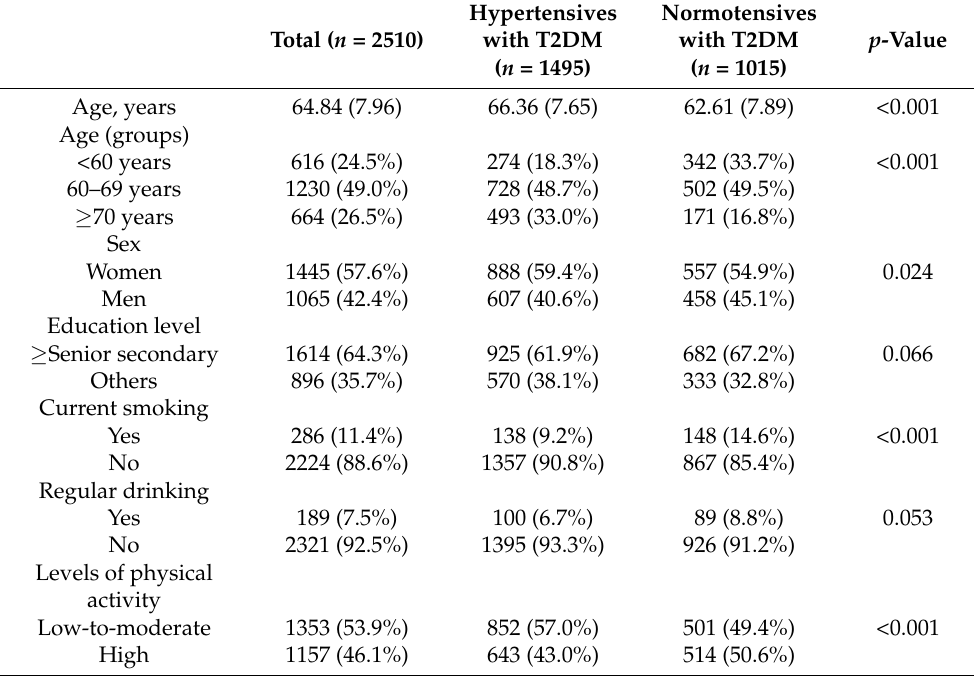
Table 1. Demographic and lifestyle characteristics of study